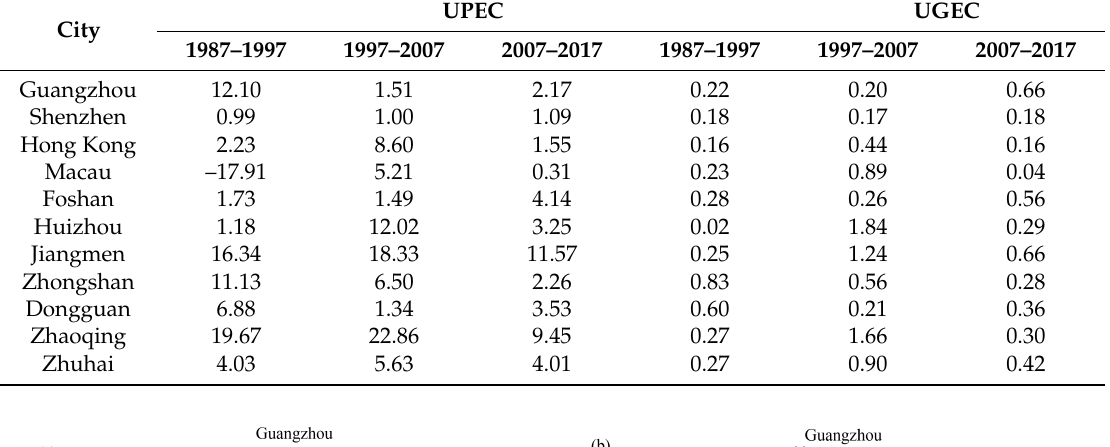
Table 7. The rationality of urban expansion in 11 cities in the GBA between 1987 and 2017. UPEC, urban area population elastic coefficient; UGEC, urban area gross domestic product (GDP) elastic coefficient. UPEC UGEC City